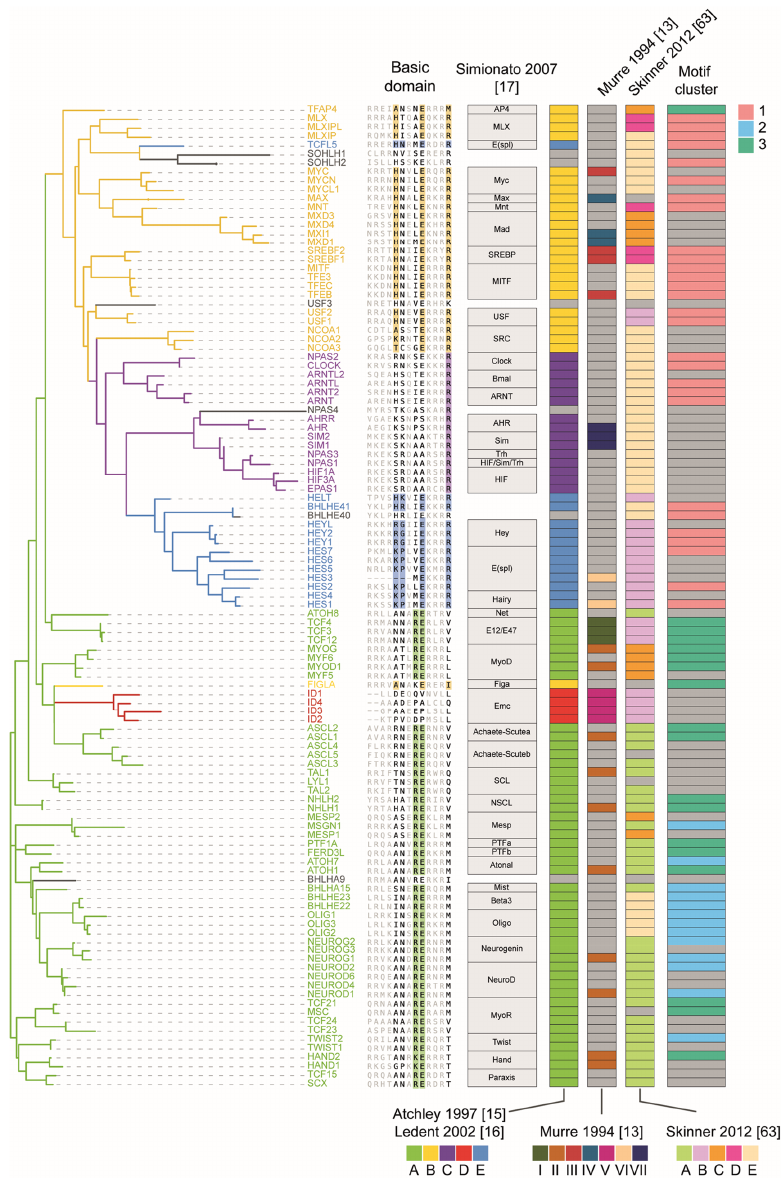
Figure 3. Representation of the phylogenetic relationships, alignment of the basic domain, and different classification systems of bHLH factors. The phylogenetic tree and the alignment were downloaded from the online database provided by Lambert et al. (http://humantfs.ccbr.utoronto.ca/dbdsTable.php?dbd=bHLH, accessed on 15 April 2021). The tree was inferred from the alignment of the whole bHLH domain, but here we only represent the basic domain as it contains the most relevant positions with respect to binding. Importantly, the tree does not imply true ancestral phylogenetic relationships among bHLH classes. The amino acids in the five positions that better separate the phylogenetic classes are colored, taking as a reference amino acids described by Atchley and Zhao [66], although we find some minor differences in those diagnostic amino acids, because they used bHLH sequences from multiple species, while we focused in human bHLH factors. In the right, different classification systems are displayed: the subfamily as annotated by Simionato et al. [17], the phylogenetic classes by Atchley et al. and Ledent et al. [15,16], the Murre classes based on both structural and functional criteria [13], the phylogenetic classes by Skinner et al. [63] inferred from the sequence of the whole protein, and finally, our clusters derived from in vitro binding affinity experiments. The boxes are colored in gray when no information about the classification was available for the corresponding gene in the corresponding original